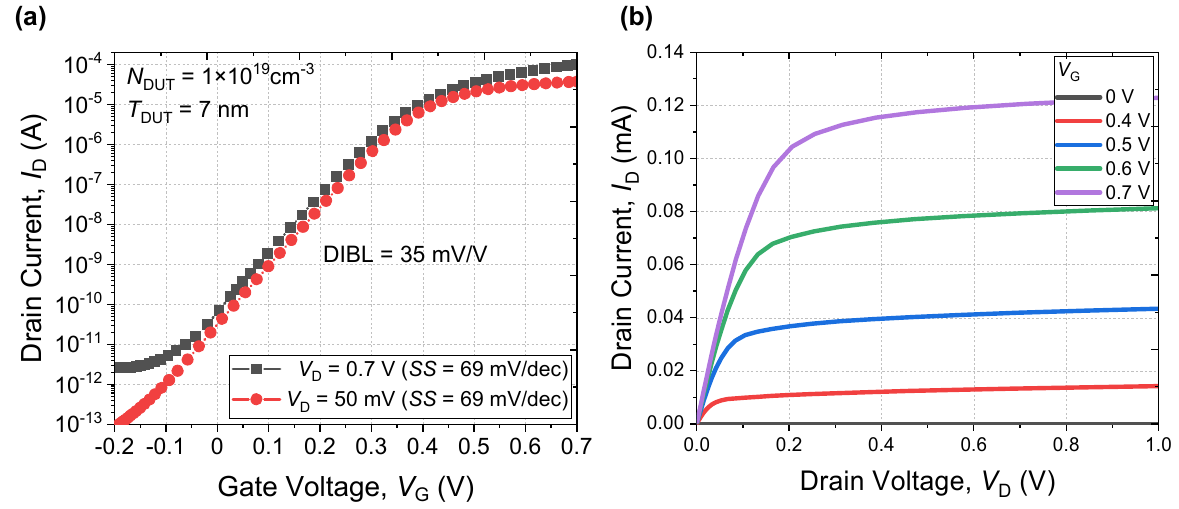
Figure 8. ( a ) Extracted I D – V G and ( b ) I D – V D characteristics of NS FET with DUT layer. Table 2. Comparison of DIBL and SS characteristics with various devices.